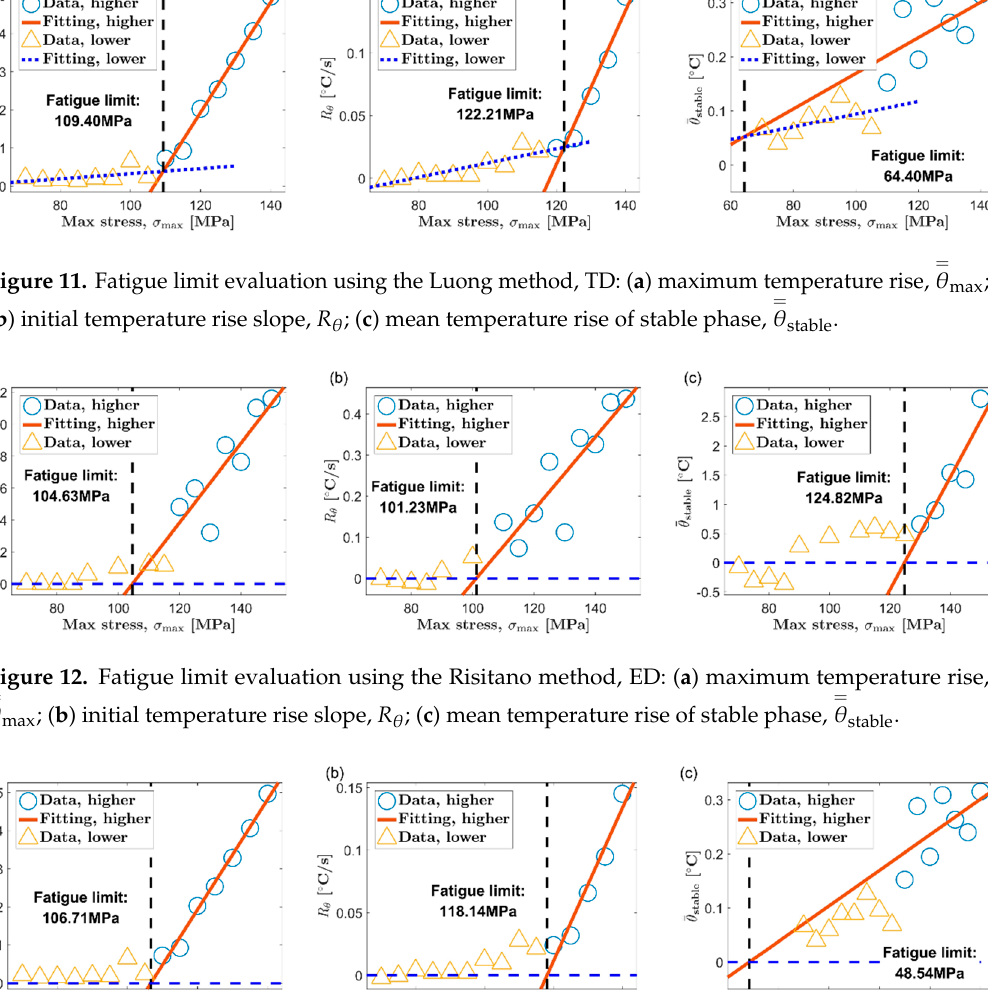
Figure 13. Fatigue limit evaluation using the Risitano method, TD: ( a ) maximum temperature rise, θ max ; ( b ) initial temperature rise slope, R θ ; ( c ) mean temperature rise of stable phase,